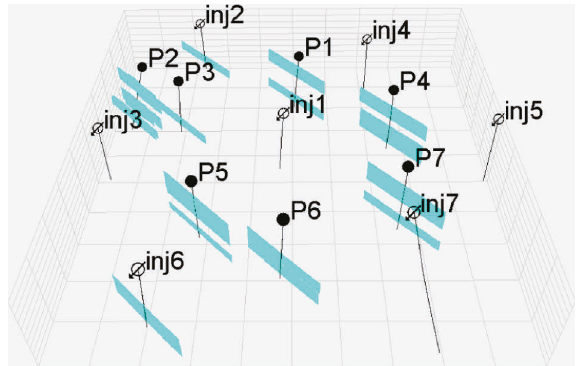
Figure 2: Three-dimensional display of fracturing model in oil and water wells.